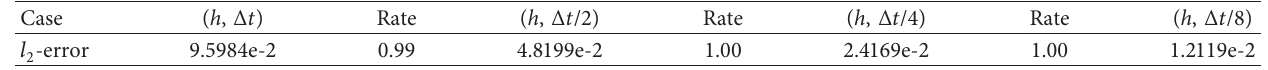
Table 11: Convergence test results of the unconditionally stable method for time step.